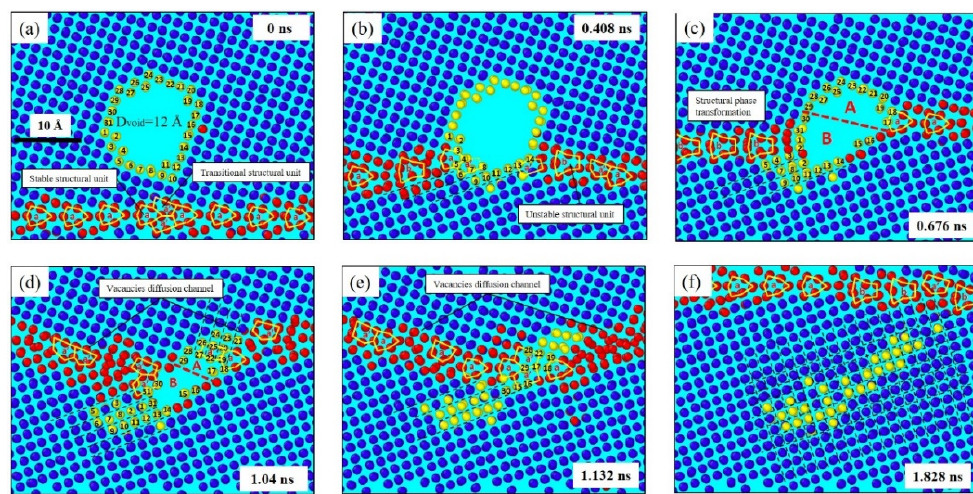
Figure 6. ( a )–( f ) Atomic view of interaction between the migrating Σ 5(310) GB and a void at different simulation time. The atoms on the void surface are colored in yellow and the structural units are outlined by the yellow solid lines. Atoms are color coded according to their structures (blue—FCC; red—other structure). Reproduced with permission from Ref. [74]. Copyright 2021 Clearance